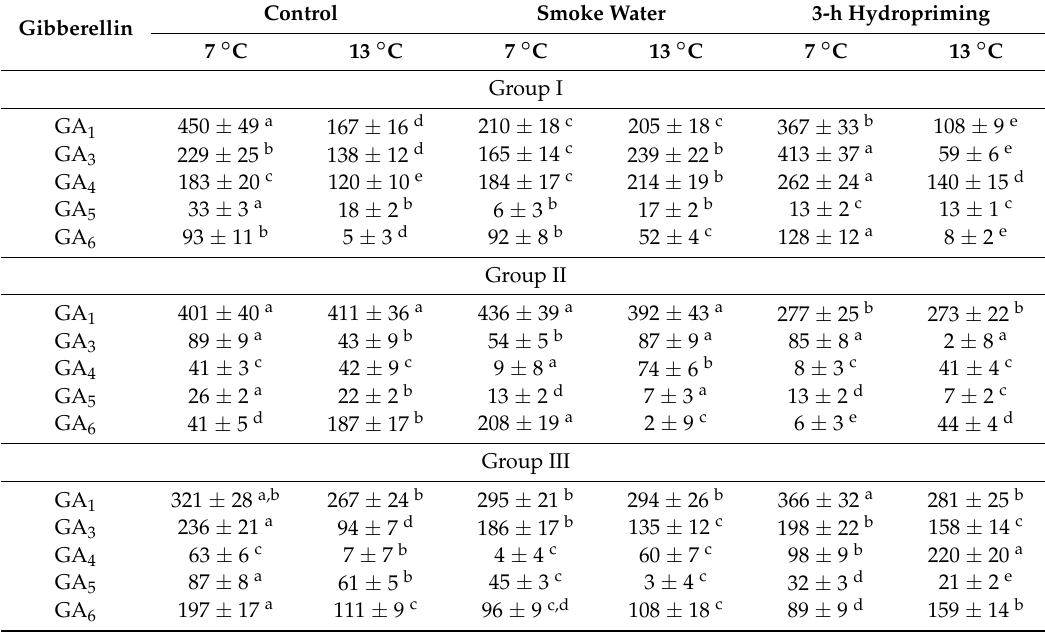
Values shown for each group are means ± SE of four lines/cultivars based on three replicates for each line/cultivar. Different superscript letters (a, b, c, ...) in the rows indicate significant differences between means (Duncan’s multiple range test; p <